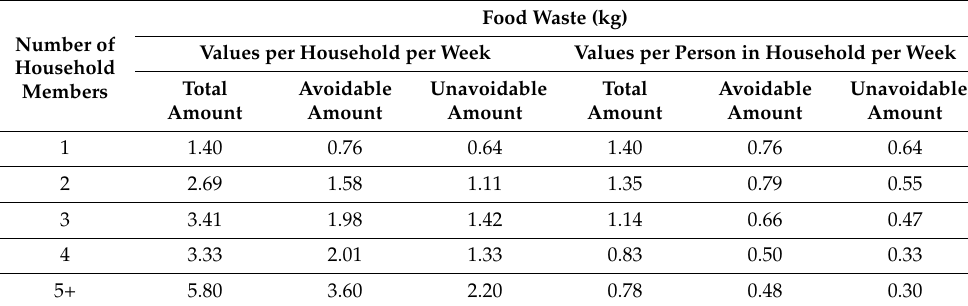
Table 4. Quantity of food waste by household size based on the one-week measurement.